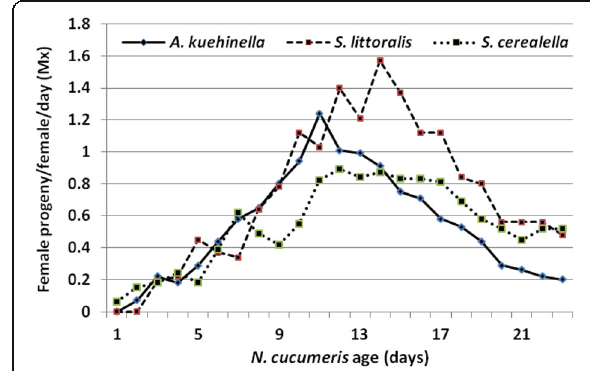
Fig. 4 Age-specific fecundity of Neoseiulus cucumeris fed eggs of Anagasta kuehniella , Spodoptera littoralis , and Sitotroga cerealella and incubated at 27 °C and 65%